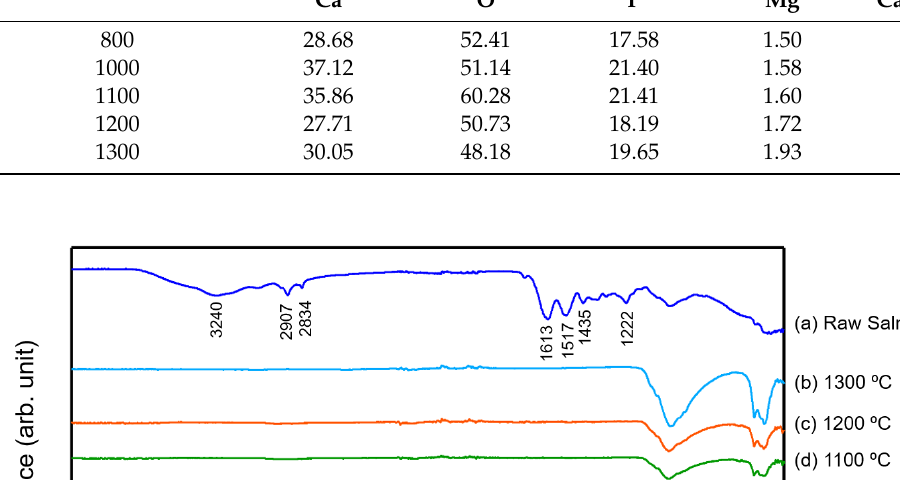
Figure 6. FTIR spectra; ( a ) raw salmon bone, ( b ) sintered sCaP at 1300 °C, ( c ) sintered sCaP at 1200